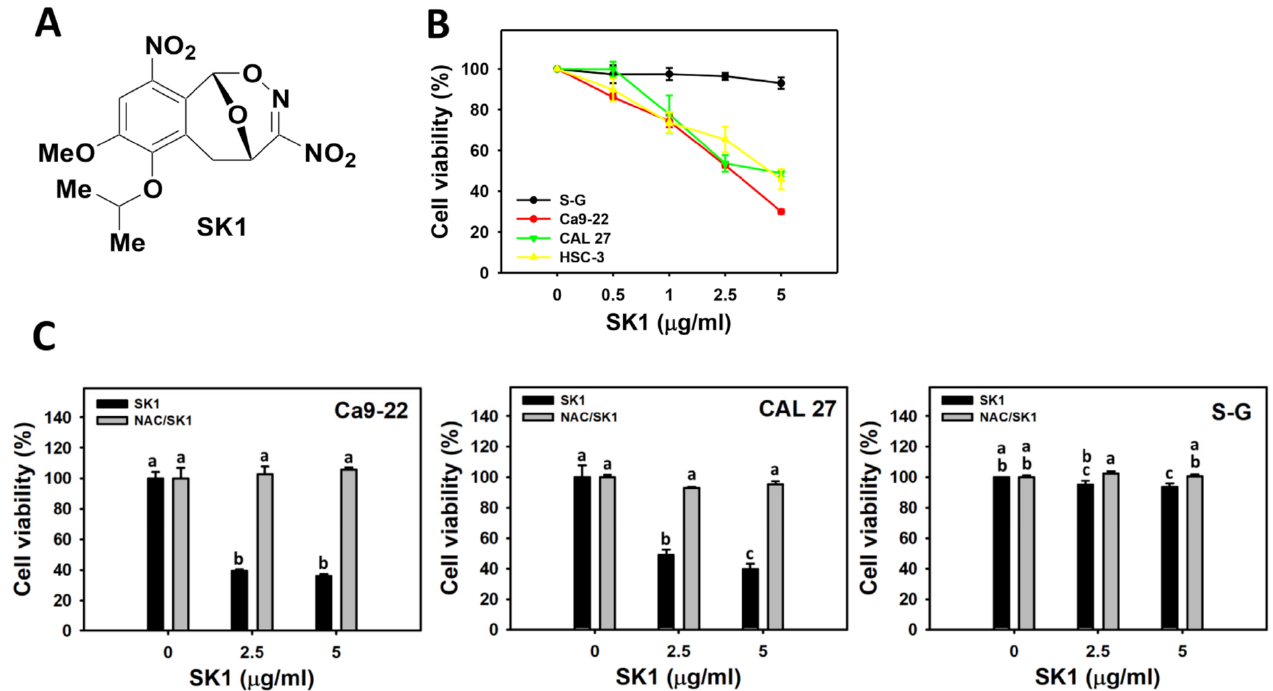
Figure 1. Structure and cell viability effects of SK1. ( A ) Structures of SK1. ( B ) 24 h MTS assay of SK1. Non-malignant (S–G) and oral cancer (Ca9-22, CAL 27, and HSC-3) cells were treated with SK1 for 24 h. ( C ) 24 h MTS assay of NAC/SK1. NAC/SK1 indicated that cells were pretreated with NAC and posttreated with SK1 (0 (0.1% DMSO in medium), 2.5, and 5 µ g/mL for 24 h). Data, mean ± SD ( n = 3). Statistical software provided non-overlapping low-case letters indicate significant results for multi-comparison ( p < 0.05). In the example of Ca9-22 cells (Figure 1C), the SK1 0 µ g/mL and NAC/SK1 0, showing “a” indicate nonsignificant results compared with each other because the letter was overlapping with “a”. In contrast, the SK1 2.5 µ g/mL and NAC/SK1 2.5, showing “c, a, and b” indicate significant results compared with each